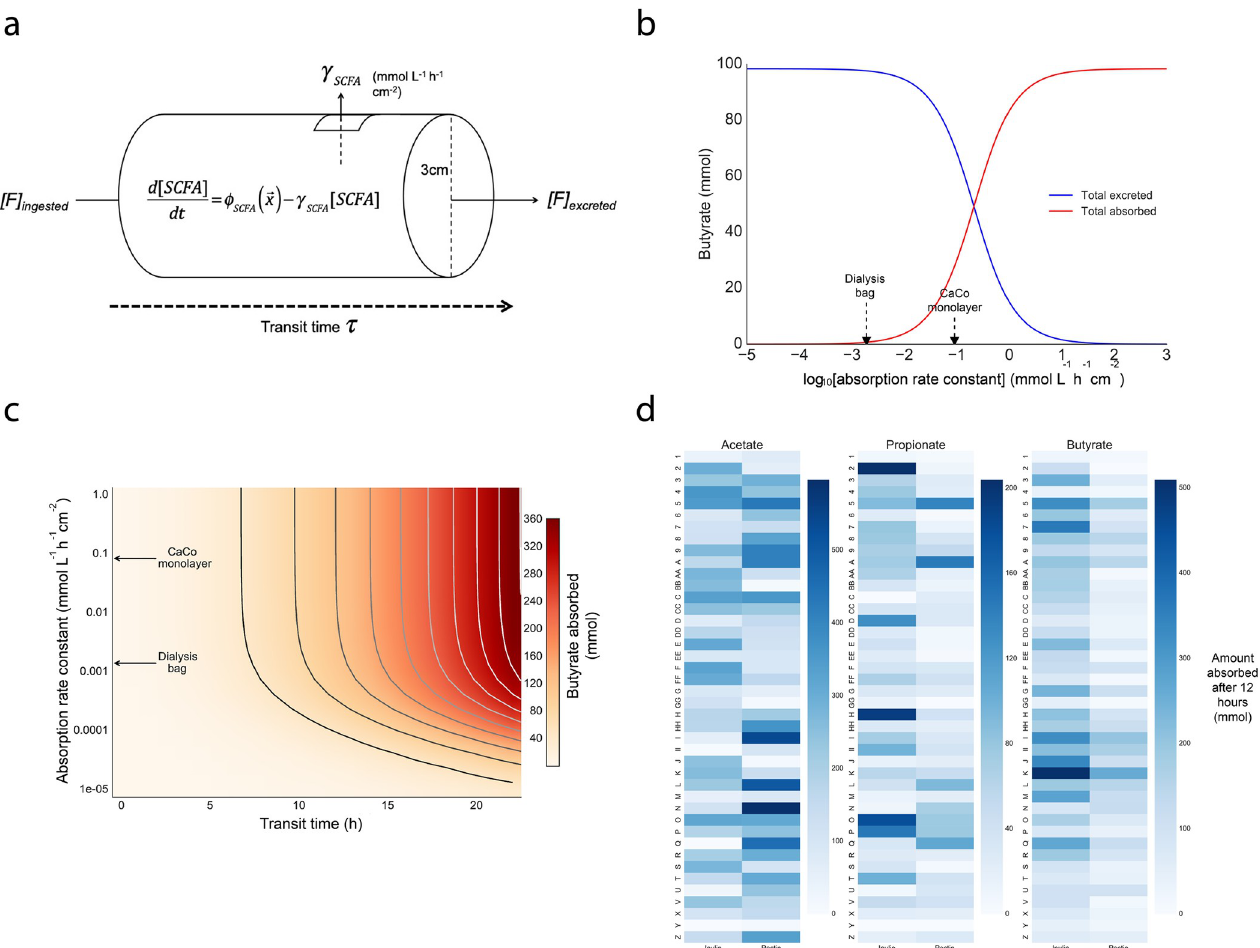
Fig 4. Phenomenological model of in vivo SCFA production predicts that inter-individual differences affects quantities absorbed. (a) Schematic of model parameters. (b) Predicted quantities of butyrate absorbed versus excreted in the stool in participant H as a function of the colonic epithelial absorption rate constant, assuming a transit time of 12 hours. Values of the rate constant measured by the dialysis bag and CaCo monolayer approaches discussed in the text are shown explicitly. (c) Phase diagram of predicted quantity of butyrate absorbed as a function of the epithelial absorption rate constant and transit time (participant H). Values of the rate constant measured by the dialysis bag and CaCo monolayer approaches discussed in the text are shown explicitly. (d) Predicted amount of each SCFA absorbed (in mmol) using a transit time of 12 hours for each subject and the dialysis bag rate constant parameters.